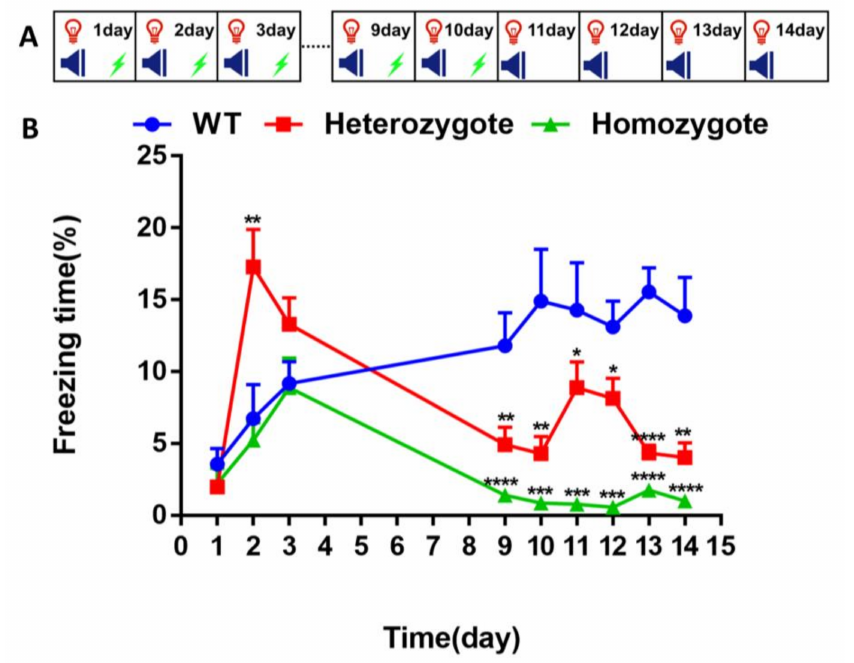
Figure 5. Inhibition of BChE enhanced fear conditioning memory and fear extinction memory in 4-month-old mice. ( A ) Experimental design for the combination of fear conditioning, re-exposure and extinction training. On days 1–3 and 9–10, the freezing time was measured during 180s of adaptation and 2 cycles of CS+US. On days 11–14, the freezing time was measured during 180s of adaptation and 2 cycles of CS. ( B ) The percentage of freezing time of wild-type (WT), BChE heterozygous, and BChE KO mice. n = 7–9 mice per group. Data were shown as mean ± SEM. * p < 0.05; ** p < 0.01; *** p < 0.001; **** p < 0.0001; versus WT group, one-way ANOVA followed by Tukey’s post hoc